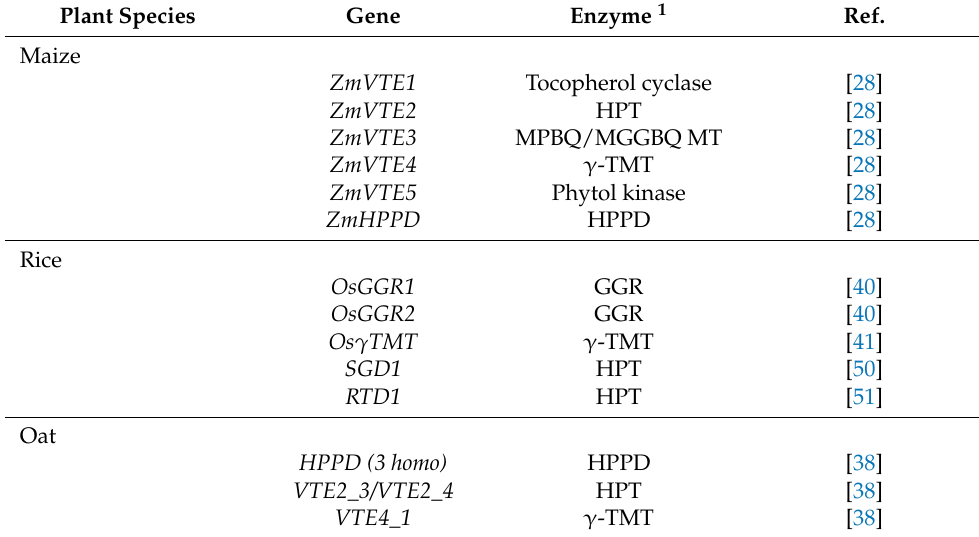
Table 1. Cont. Plant Species Gene Enzyme 1 Ref.